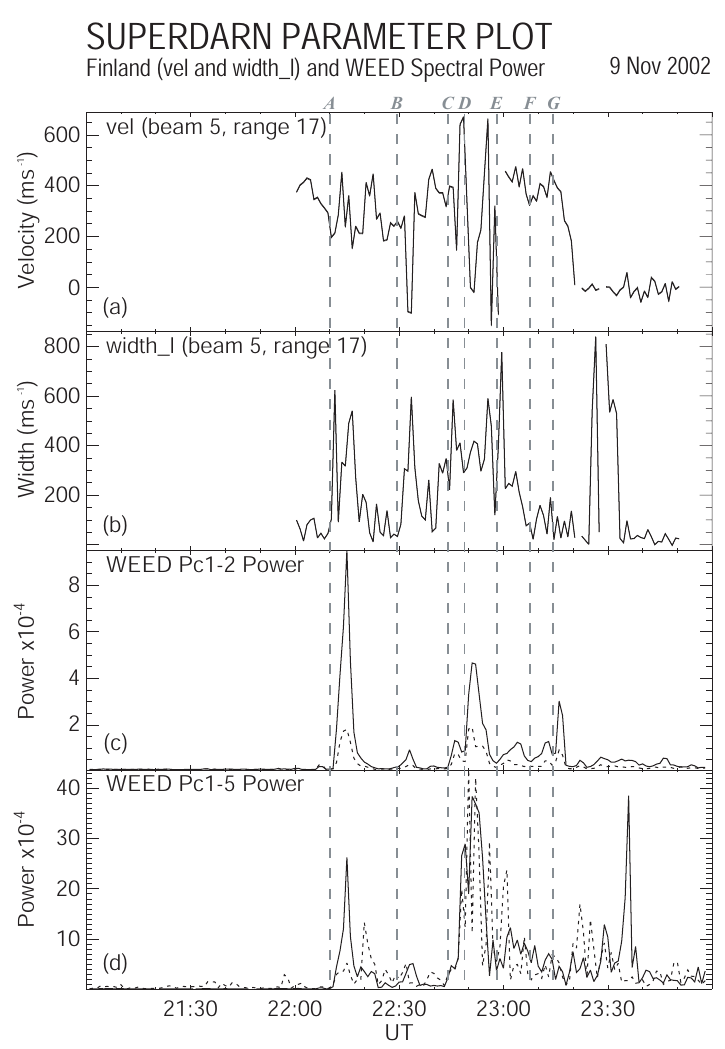
Fig. 2. Stacked time series of the line-of-sight velocity (a) and spectral width (b) from range 17 on beam 5 of the CUTLASS, Finland radar along with WEED summed spectral power in the (c) 0.1–5Hz and (d) 0.002–5Hz frequency bands (solid line: − dD/dt; dashed line: −